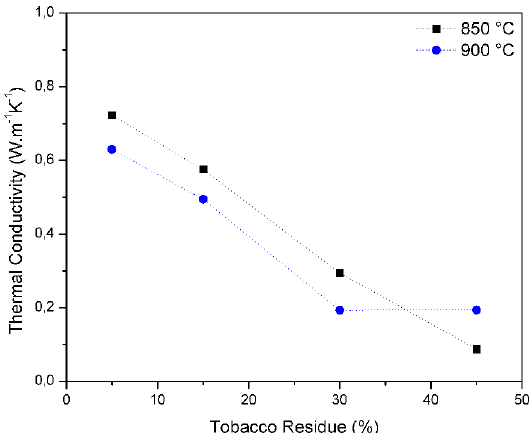
Figure 5. Thermal conductivity for glass foams produced after addition of 5, 15, 30 and 45% (mass) of T and fired at 850 °C and 900